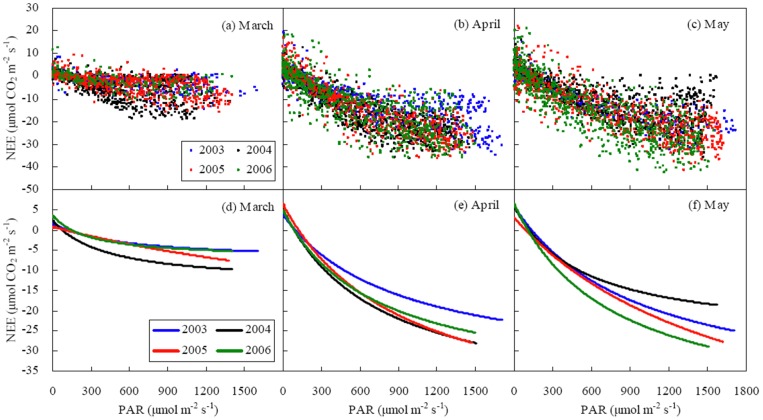
Response of net ecosystem CO2 exchange (NEE) to photosynthetically active radiation (PAR) in a winter wheat field.a–c: NEE obtained by eddy covariance technique; d–f: light response curves fitted monthly using the rectangular hyperbolic function (Eq. (3)). The values of light response parameters were shown in Table 1.